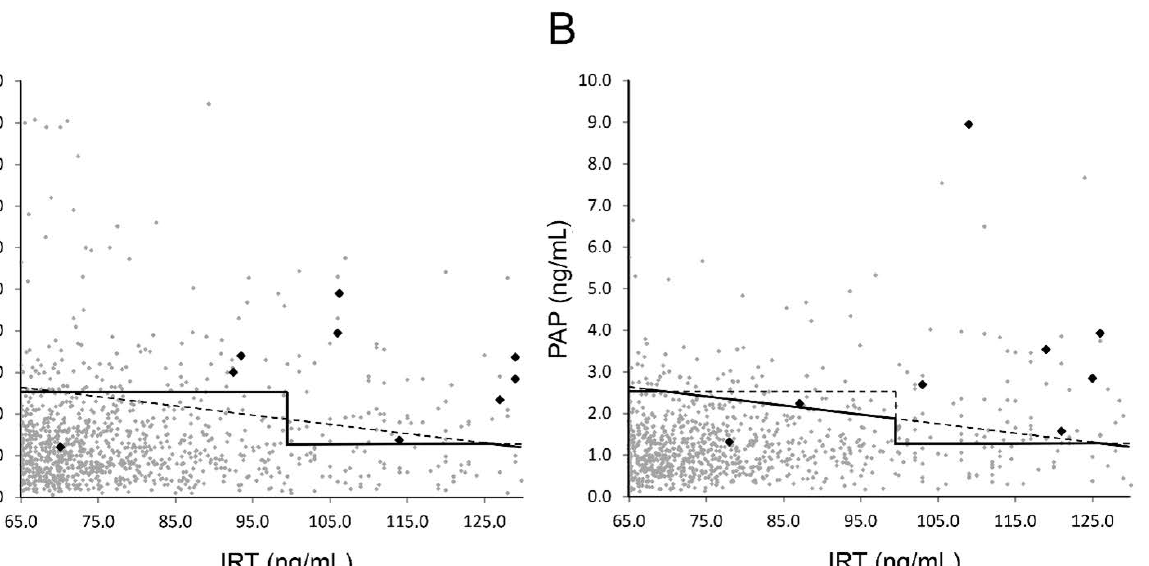
Table 2. Comparison of different CF screening algorithms in Austrian newborn screening.